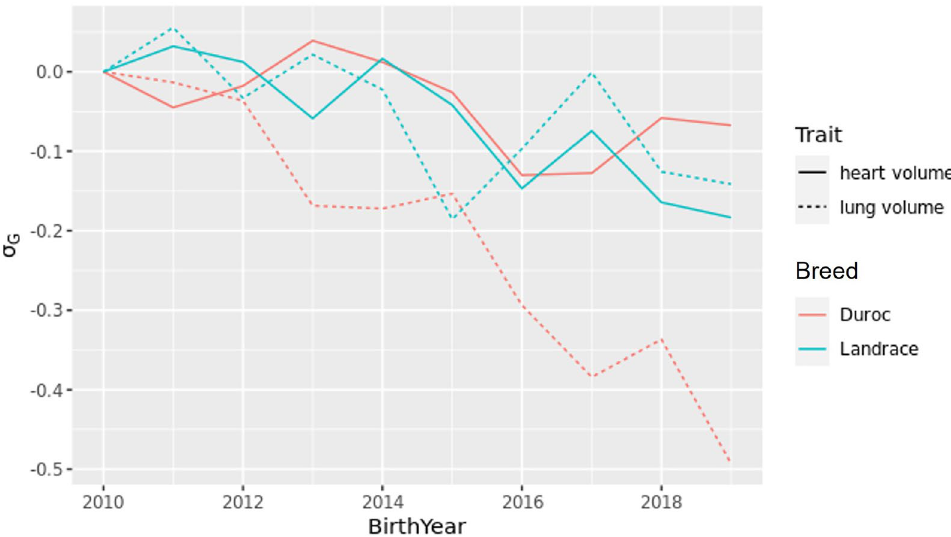
Figure 3. Genetic trends of heart and lung volume, scaled according to the genetic standard deviation, σ G of the trait.